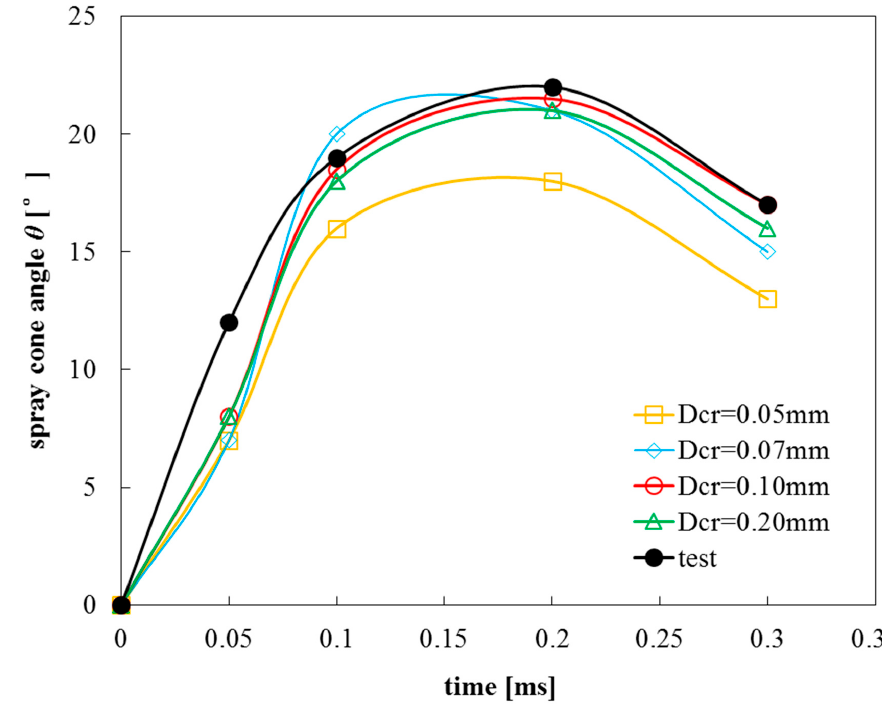
Figure 12. Spray cone angle.